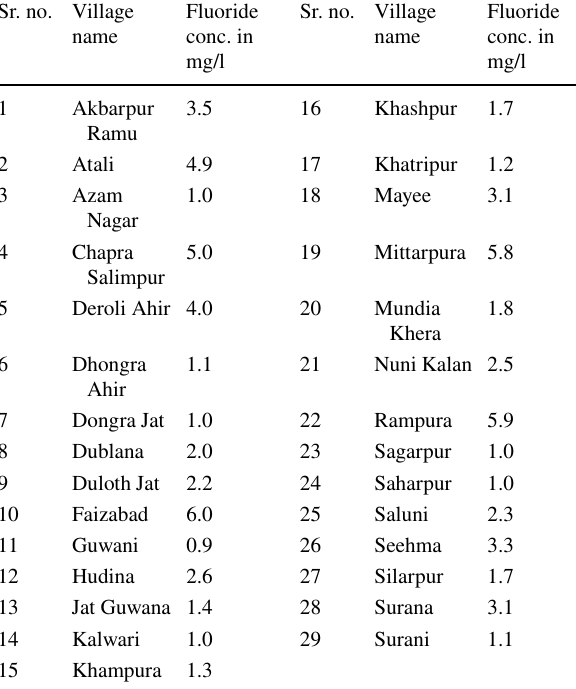
Table 3 Showing the average fluoride concentration in villages of Table 4 Showing the average fluoride concentration in villages